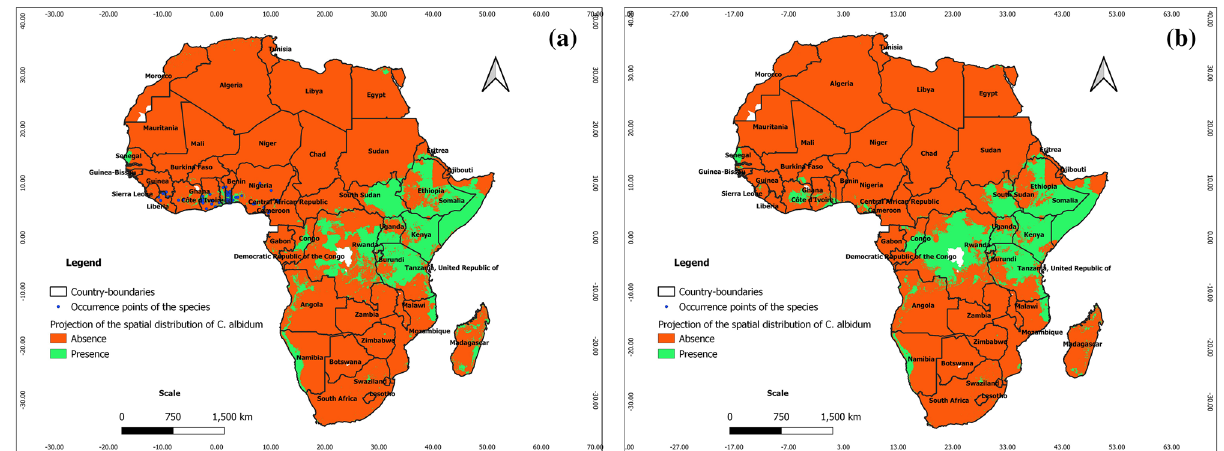
Figure 6. Projections of the spatial distribution of C . albidum according to RF across Africa: a) at present with occurrence points; b) at horizon 2060 SSP585 (the maps were generated using R version 4.1.3 (https:// www.R- proje ct. org/), QGIS 3.18.1 (http:// qgis. osgeo. org), and WGS 84 as Coordinate Reference System).